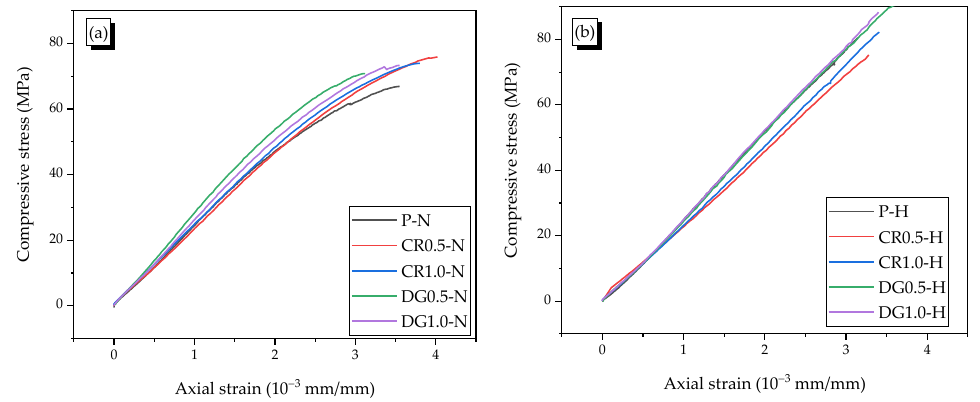
Figure 7. Typical axial stress – strain curves, ( a ) Non-heating case, ( b ) Heating case. Table 3. Poisson’s ratios and secant dilation ratio in the monotonic compressive test.